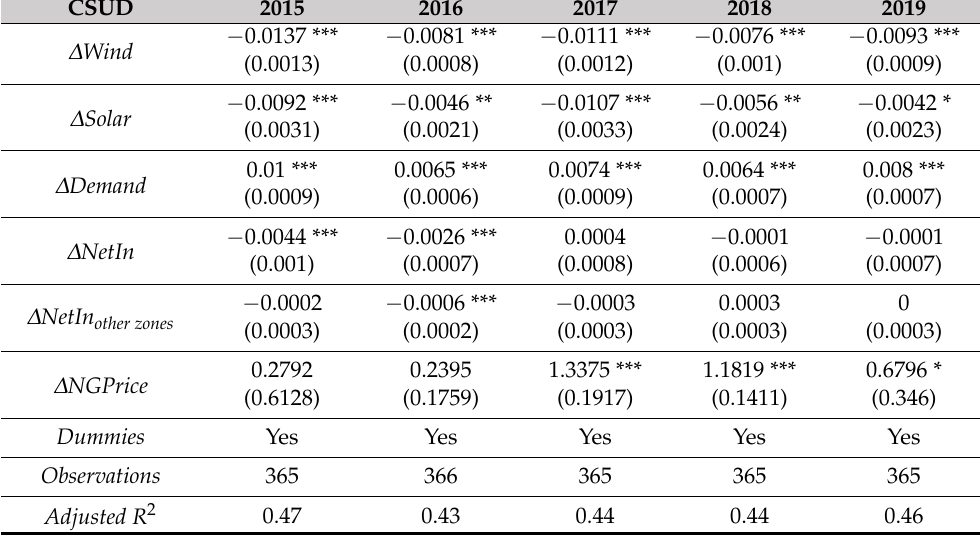
Table A14. OLS estimation of daily changes in electricity prices of CSUD; results of Equation (3). CSUD